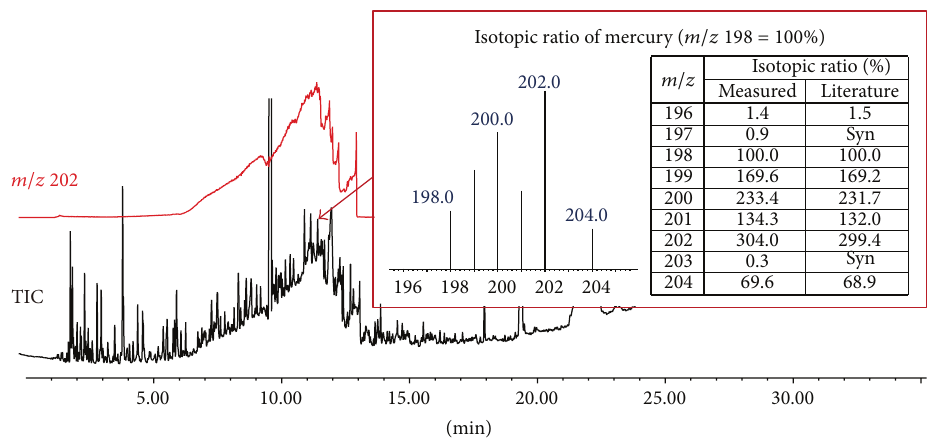
Figure 10: TIC and ion chromatograms of the 𝑚/𝑧 202 fragment ion of Sample